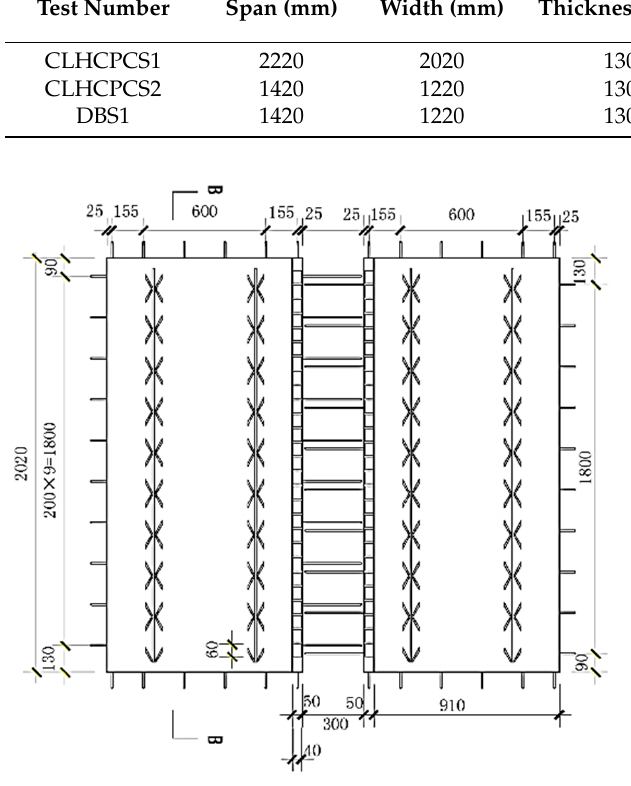
Figure 1. CAD model dimension of CLHCPCS 1.